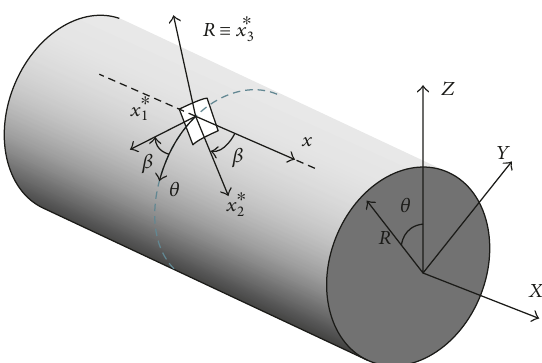
Figure 2: Location and coordinates of a strain gauge placed on the beam external